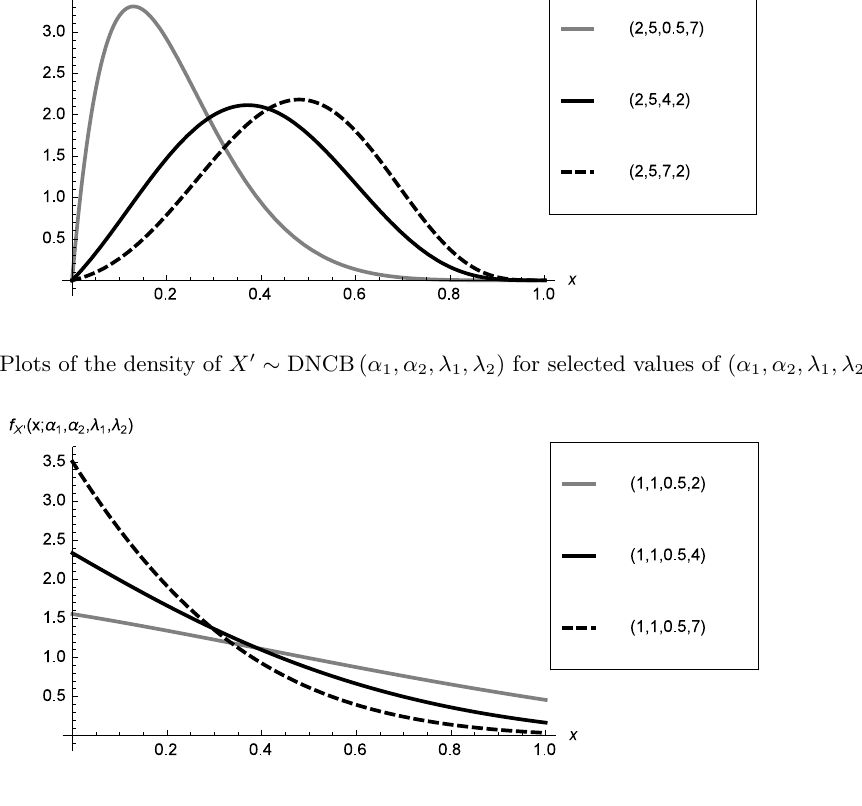
Figure 4 { Plots of the density of X ′ (cid:24) DNCB ( (cid:11) 1 ; (cid:11) 2 ; (cid:21) 1 ; (cid:21) 2 ) for (cid:11) 1 = (cid:11) 2 = 1 and selected values of (cid:21) 1 ; (cid:21) 2